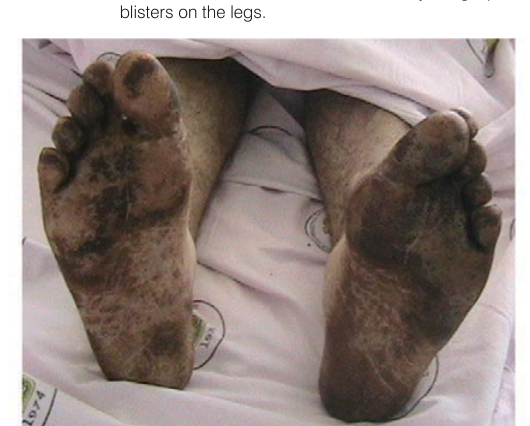
Figure 1. Erythematous macules, bullae and erosion on face, and hemorrogic crust on lips.